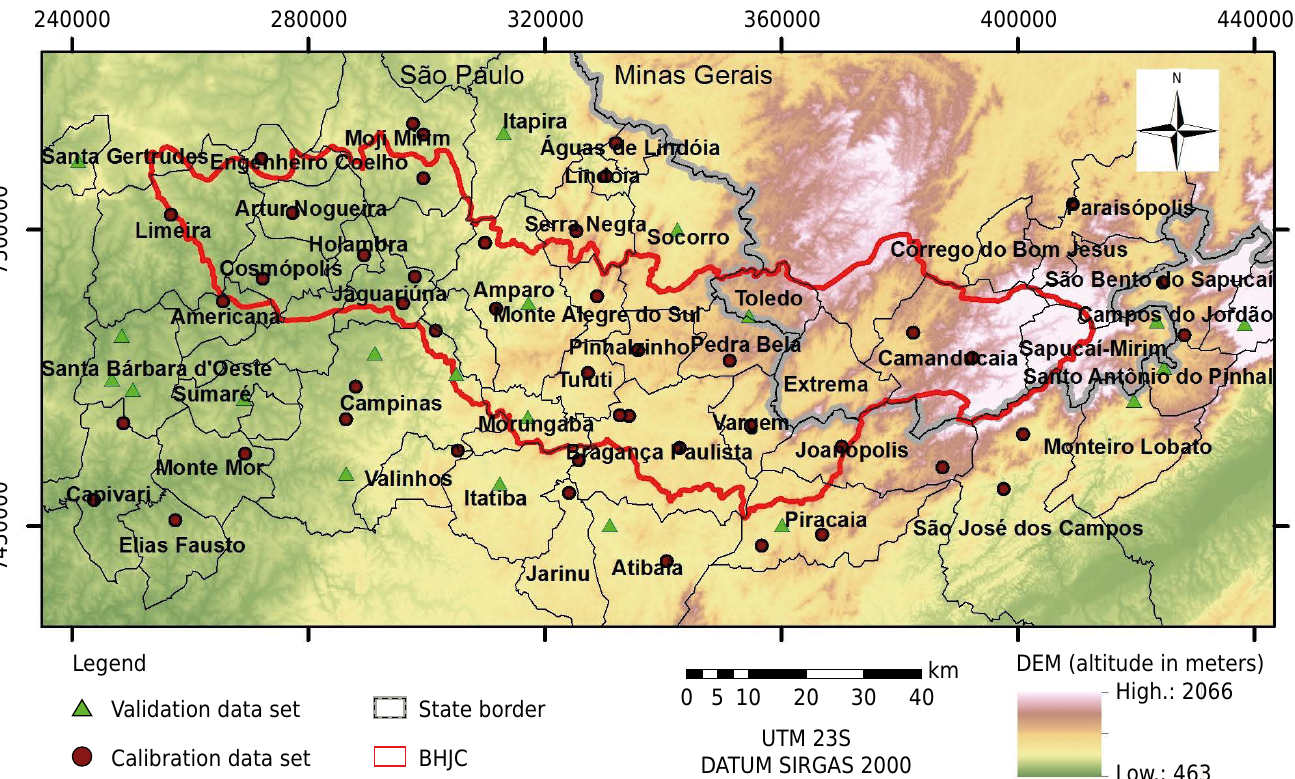
Figure 1. Jaguarí River Basin digital elevation model (DEM) and the rain gauge station locations and municipalities. DEM data: 90 m spatial resolution SRTM image between coordinates -23.24° and -22.31° S and 47.74° and 45.39°